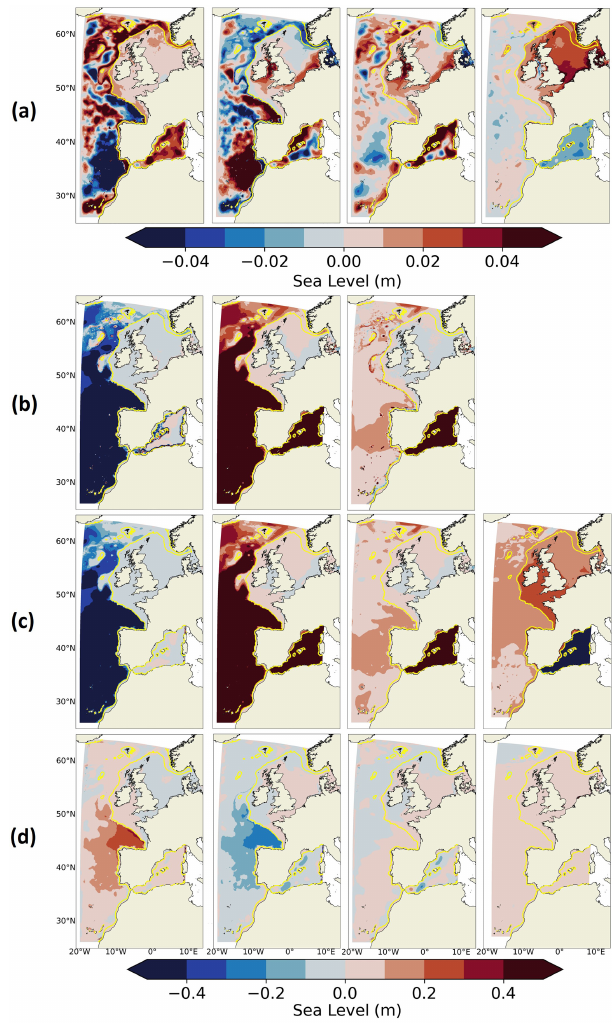
Figure 3. Thermosteric (first column), halosteric (second column), steric (third column) and manometric (last column) SL bias over 1993–2014 between (a) IBI-ERAi and IBIRYS, to show biases in the IBI-ERAi simulation, and between (b) CNRM-CM6-1-HR and IBI-ERAi, (c) IBI-CCS_raw and IBI-ERAi, (d) IBI-CCS_corr and IBI-ERAi. Manometric SL biases between CNRM-CM6-1-HR and IBI-ERAi are not shown here as they mostly display the differences of bathymetry between the two models. The thermosteric, halosteric and steric components have been computed over 0–2000m depth. Note the different color bars in panel (a) and in panels (b, c, d) . The shelf break (defined by the 200m isobath) is indicated in